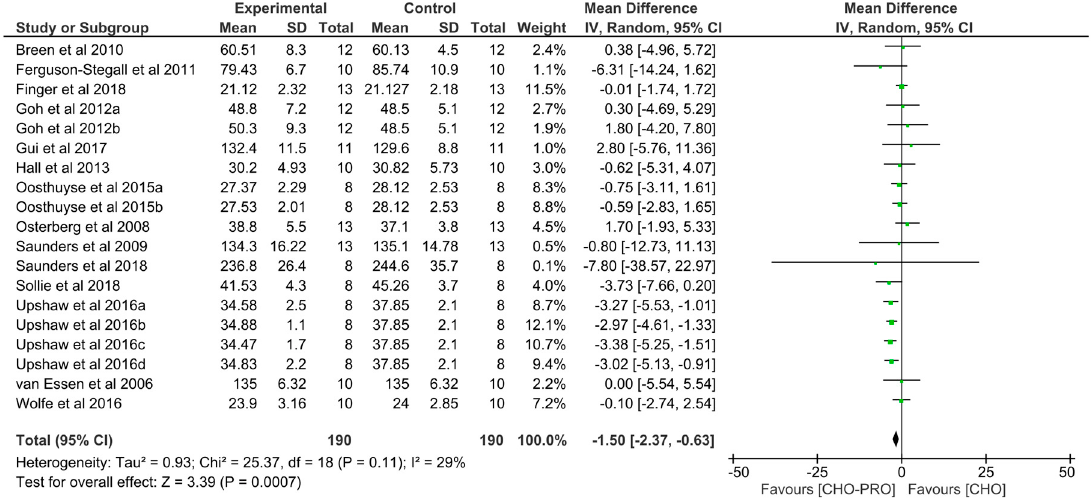
Figure 10. E ff ect of CHO-PRO on TT performance compared to CHO. CI: confidence interval; MD: Figure 10. Effect of CHO-PRO on TT performance compared to CHO. CI: confidence interval; MD: mean di ff mean difference.